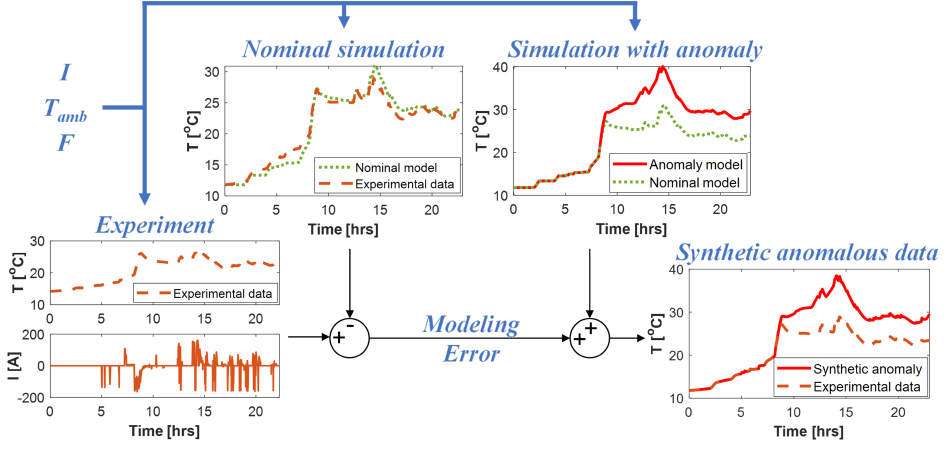
Figure 2. Flow chart for synthetic data generation for an air–flow